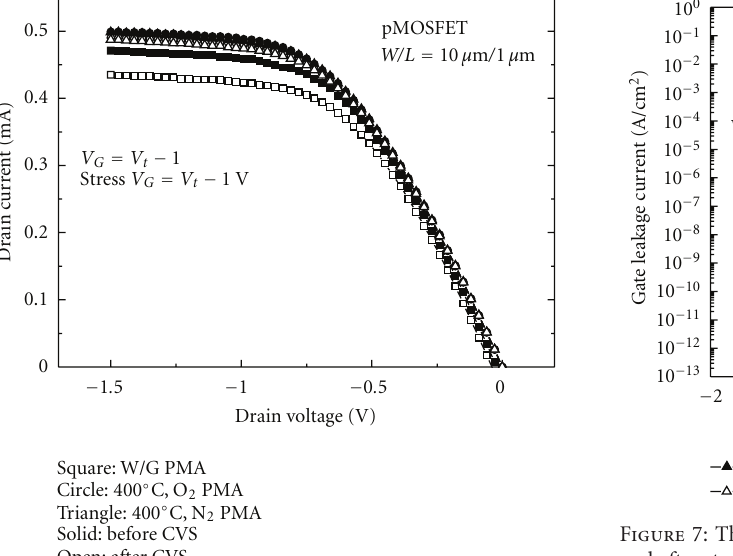
Figure 5: I D - V D curve of pMOSFET with various PMA conditions before and after constant voltage stress.